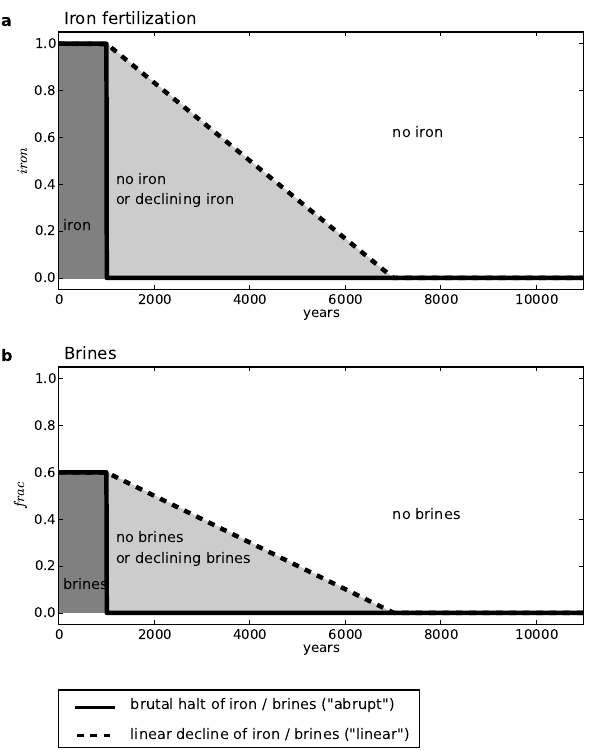
Fig. 1. Evolution scenarios for iron fertilization and the sinking of brines with a constant climate. The two processes are active at the beginning of the simulations; then they stop. This stop can be sudden or follow a linear decline.